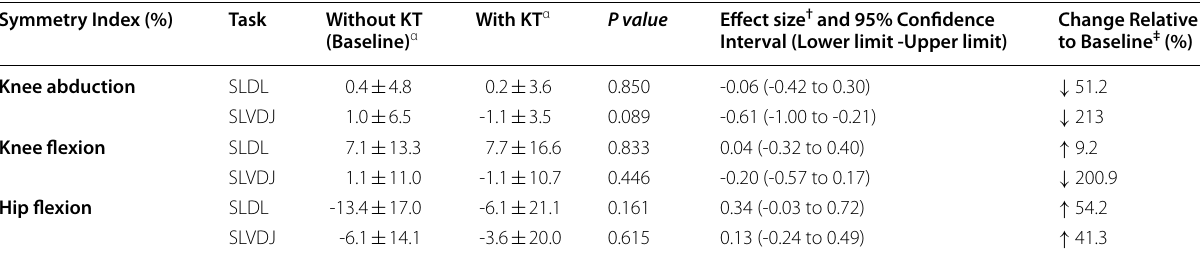
Table 4 Changes of limb symmetry index (SI) during SLDL and SLVDJ for knee abduction, knee flexion and hip flexion